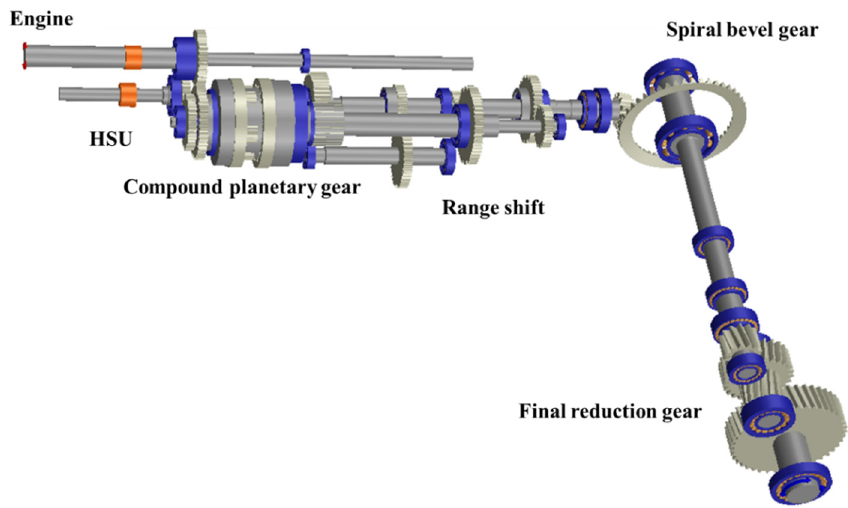
Figure 4. Simulation model for the power transmission system of the HMT using Romax DESIGNER.